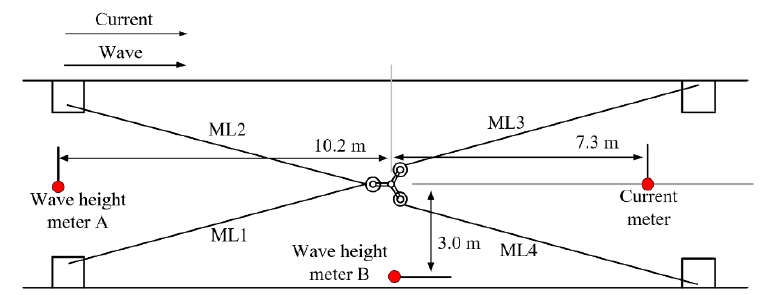
Figure 8. Overview of the water tank and platform.